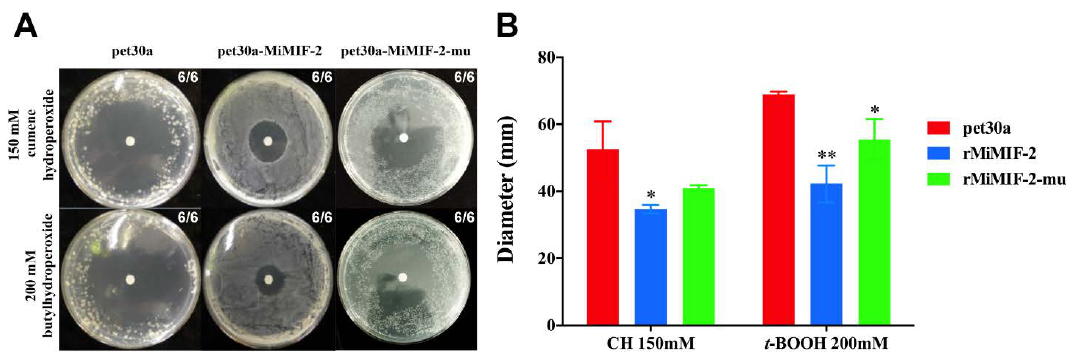
Figure 2. MiMIF-2 expression in Escherichia coli exhibited resistance to organic peroxide; ( A ) Sensitivity to cumene hydroperoxide (CH) or t -butyl hydroperoxide ( t -BOOH), measured in the filter disc assay in Escherichia coli expressing MiMIF-2 or MiMIF-2-mu. Cells containing the empty plasmid pet30a were used as controls. The numbers indicate summary statistic data for Petri dishes with similar